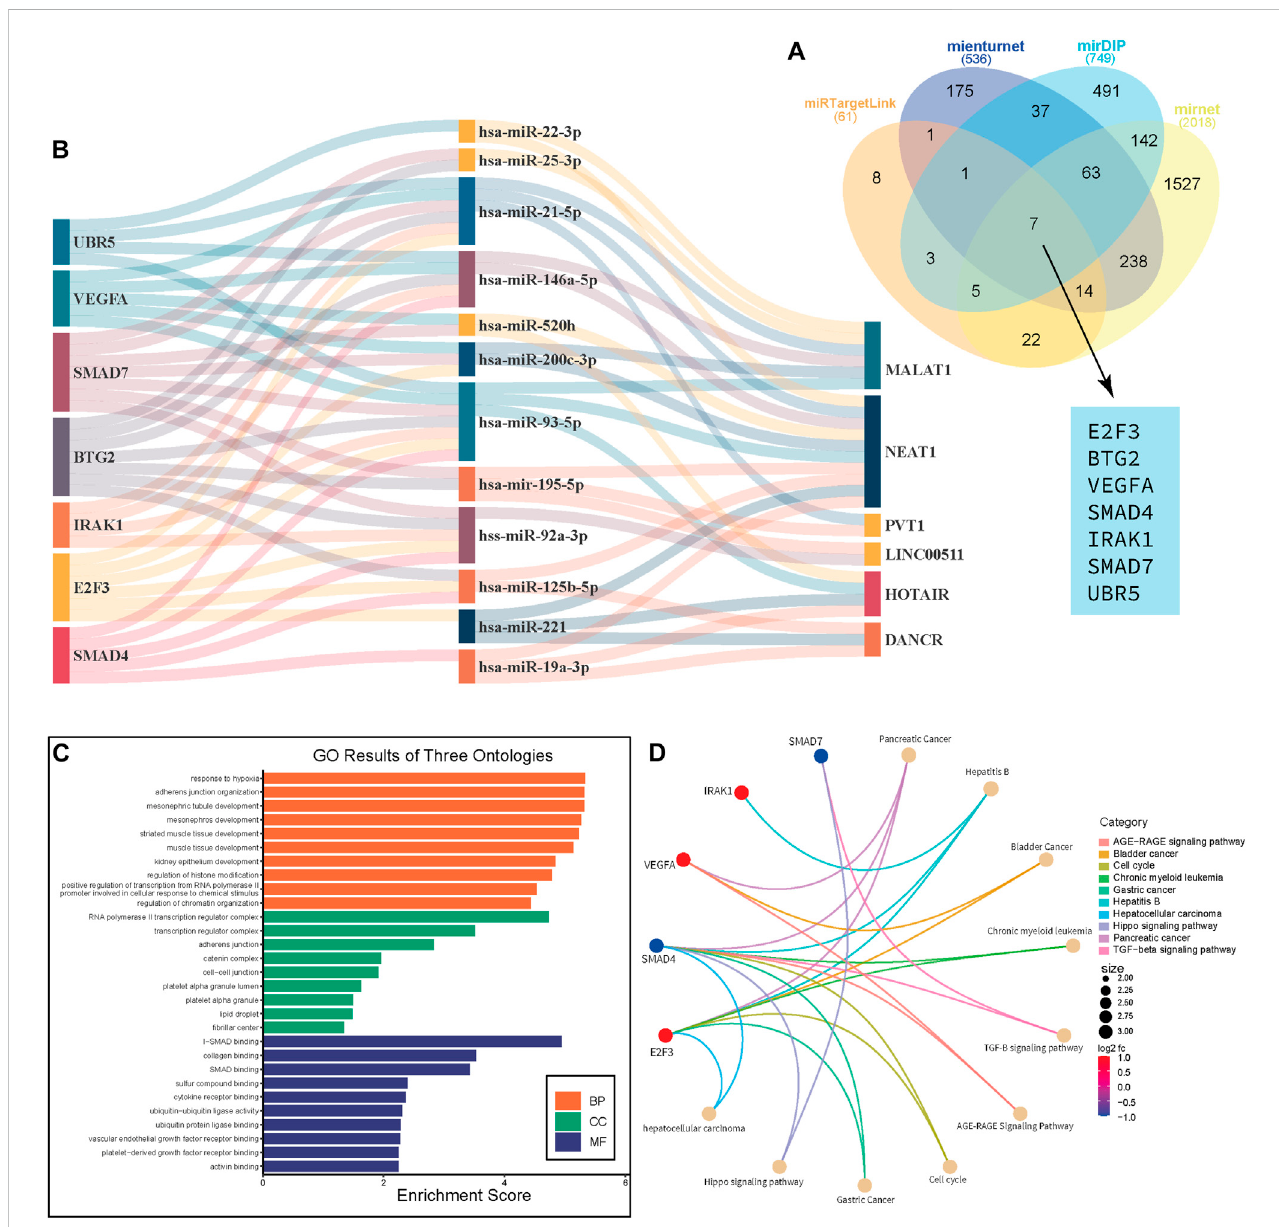
FIGURE 4 Gene Ontology and pathway analysis. Venn diagram shows the common genes that are targeted bymiRNAs in thisstudy. (A) Sankey diagram that shows thenetwork between mRNA-miRNA-lncRNA. (B) GO enrichmentanalysisrevealsBB, CC,andMF for target genesoflncRNAs. (C) CircosplotdepictstheQ28 pathways in which these genes are involved (D)